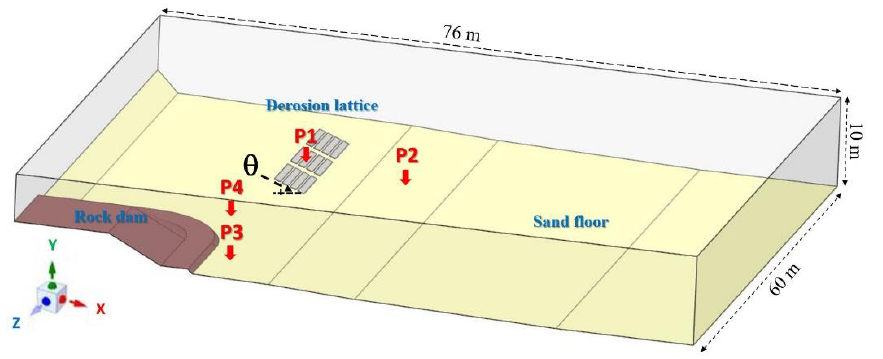
Figure 7. An example of fluid model.